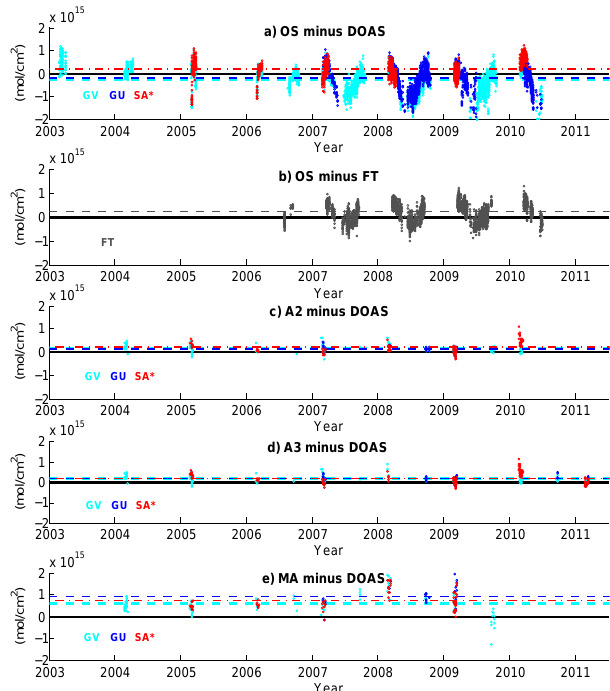
Fig. 12. Absolute difference between satellite and GBS-vis (cyan), GBS-UV (blue), SAOZ (red), and Bruker FTIR (grey) partial columns of NO 2 . Dashed lines indicate mean absolute difference. The black line indicates the zero